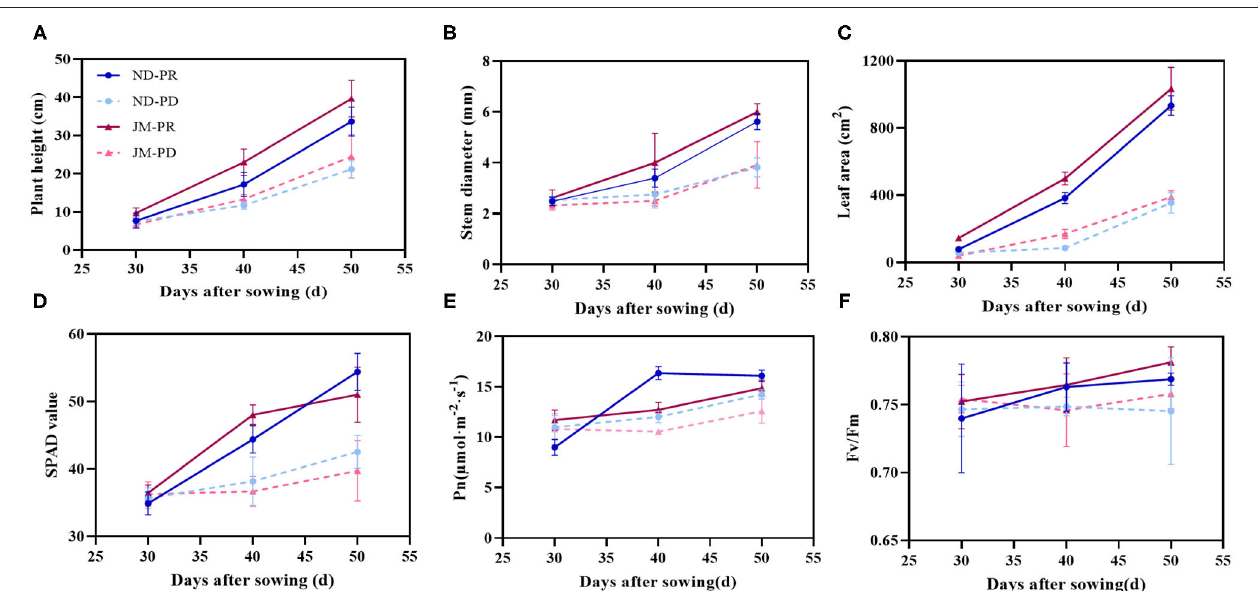
FIGURE 2 | Seedlings of two cotton cultivars grown under P-replete (PR) and P-deficient (PD) conditions for 50 days. Plant height (A) , stem diameter (B) , leaf area (C) , SPAD value (D) , net photosynthetic rate (Pn) (E) , and the maximum photochemical efficiency ( F v / F m ) (F) . ND-PR, “Nongdamian No. 10” cultivar under replete phosphorus conditions; ND-PD, “Nongdamian No. 10” cultivar under low phosphorus; JM-PR, “Jimian 315” cultivar under replete phosphorus conditions; JM-PD, “Jimian 315” cultivar under low phosphorus. Depicted are the means of six replicates ± standard